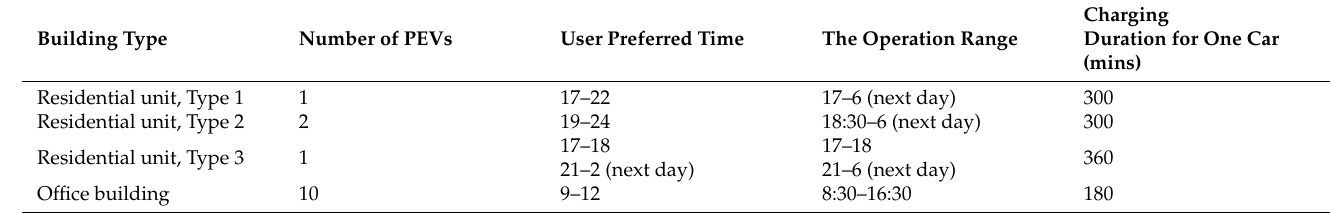
Table 3. The schedules of PEV charging assets.